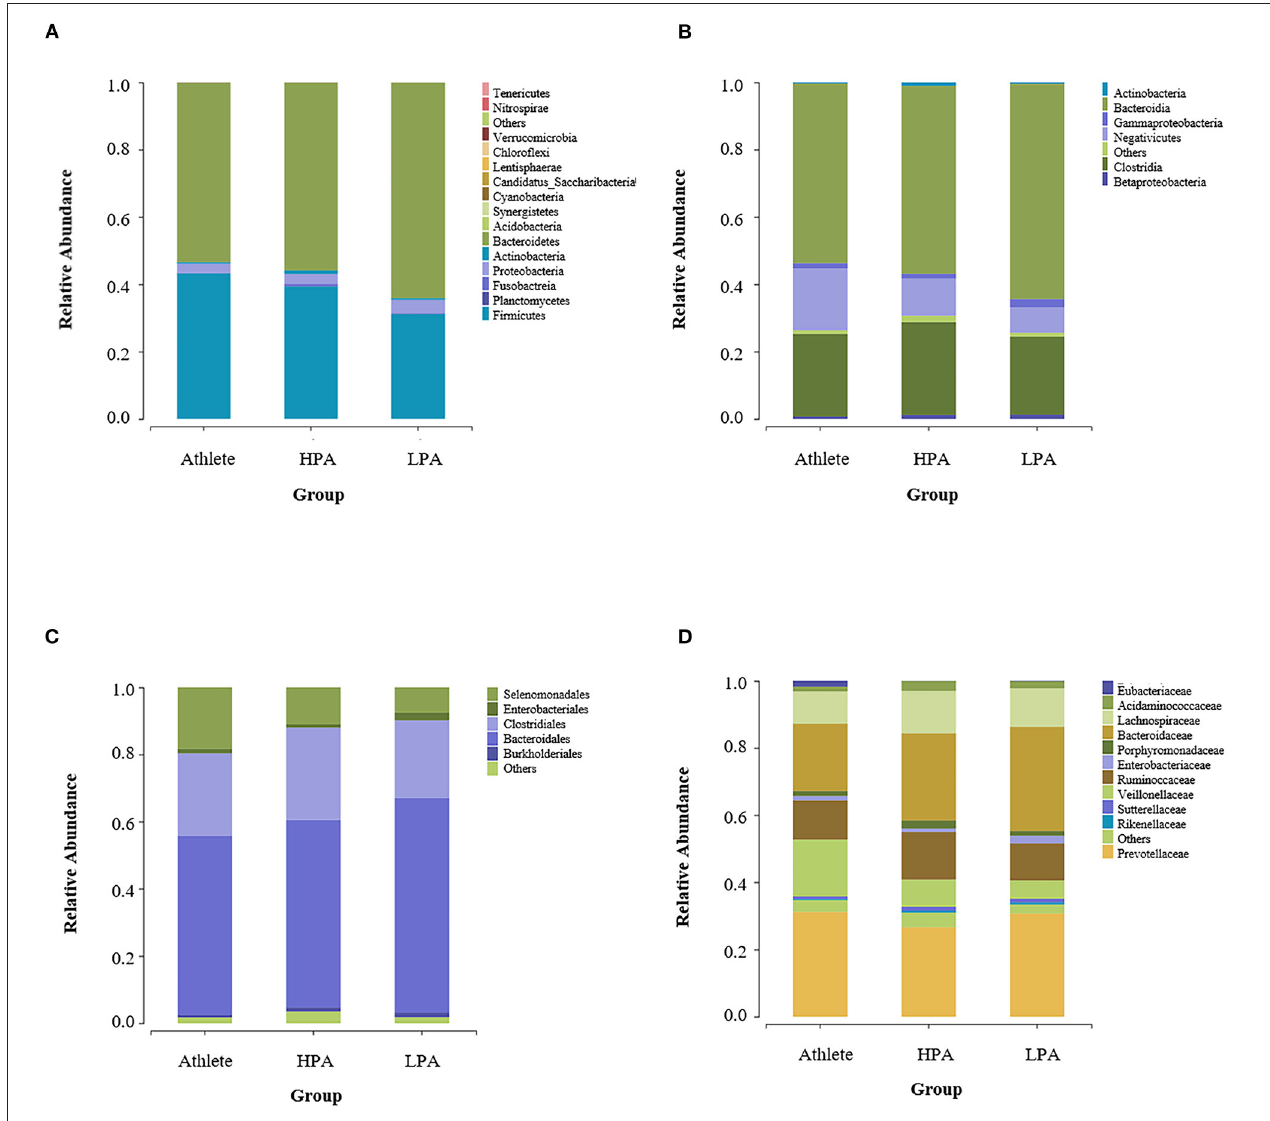
FIGURE 2 | Differences of gut microbiota relative abundance at the phylum, class, order, and family levels among three groups. Relative abundance represents the proportion of each species in each group. (A) phylum level; (B) class level; (C) order level; and (D) family level. Athlete, Athlete group; HPA, High physical activity group; LPA, Low physical activity